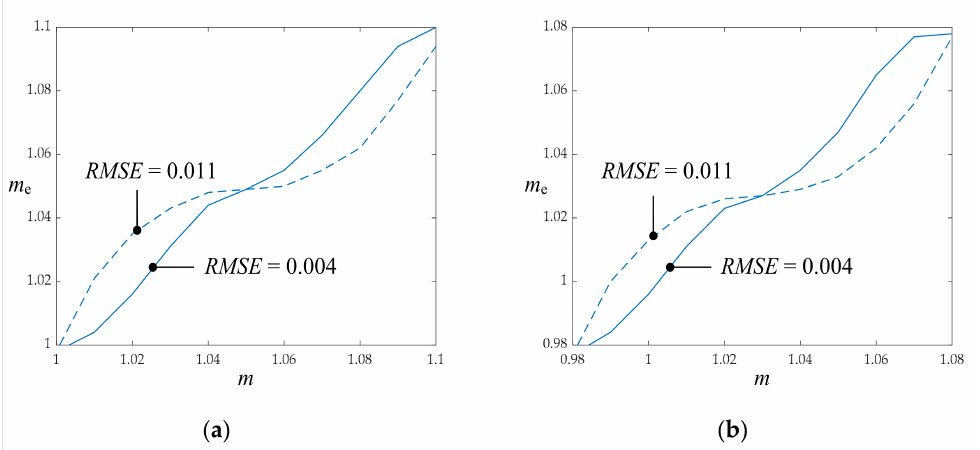
Figure 9. Effective modulation index ( m e ) as a function of the commanded modulation index ( m ) in the overmodulation region for two cases: algorithm implemented with Algorithms 1 and 2 (solid line) and algorithm implemented with Algorithms 2 and 3 (dashed line). ( a ) hbc = 1; ( b ) hbc =